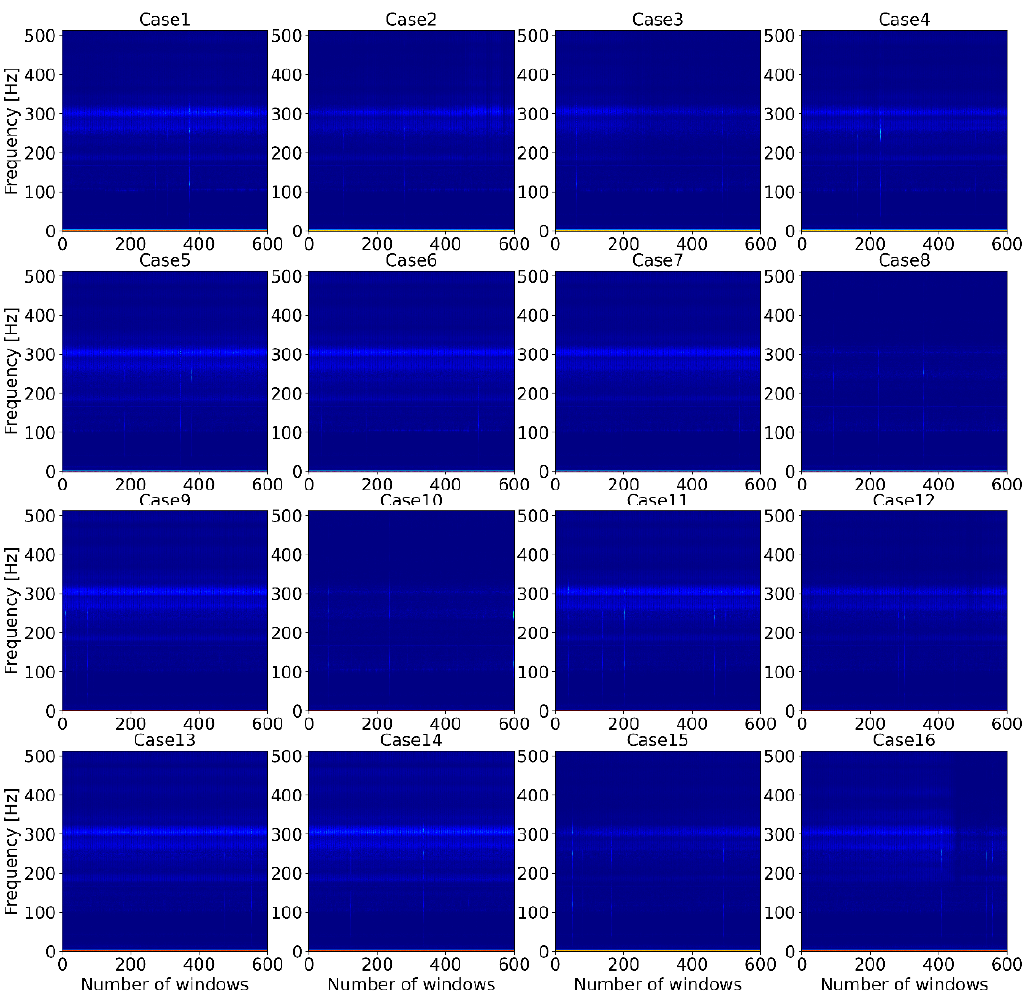
Figure 3. Rows of vibration signals of the dataset corresponding to all cases.